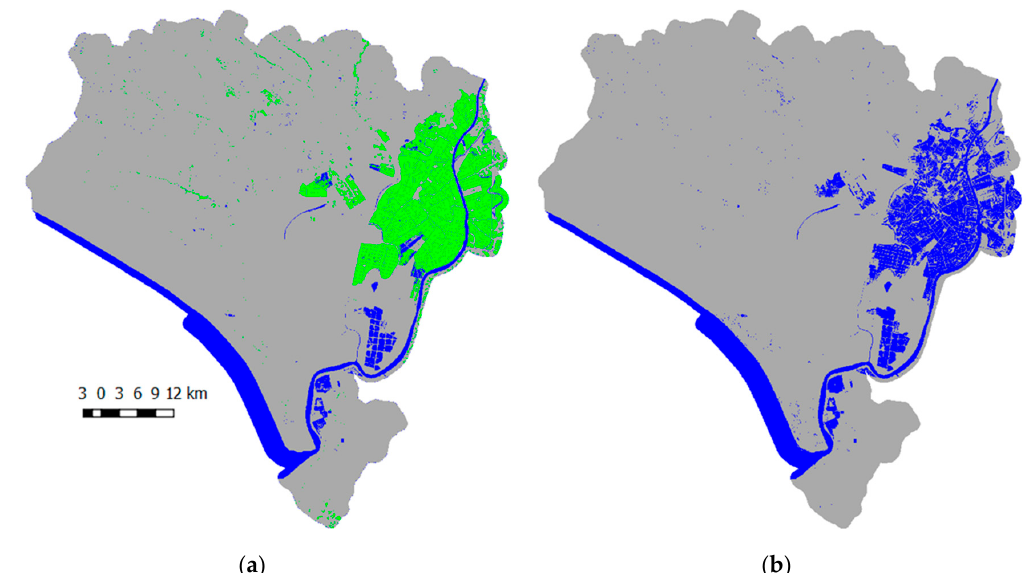
Figure 11. ( a ) Unsupervised inundation map on 20 August 2017 containing two classes of pixels: (i) water class pixels (including open-water pixels denoted with blue and water-vegetation pixels denoted with green) and (ii) non-water class pixels with gray; and ( b ) supervised inundation map on 20 August 2017 containing two classes of pixels: (i) water class pixels denoted with blue and (ii) non-inundated pixels with